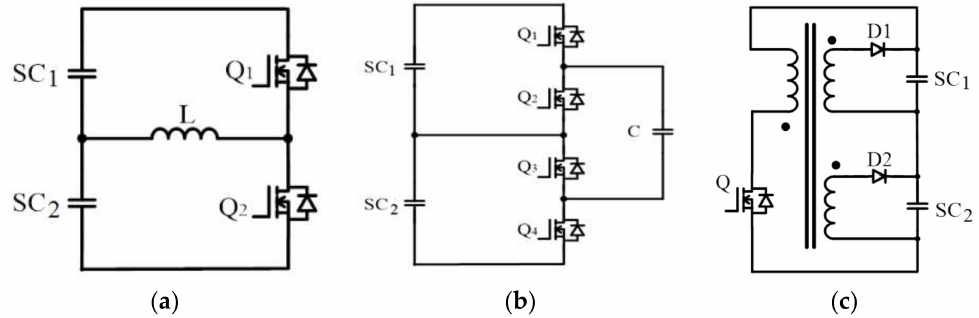
Figure 1. Basic topology of cell-balancing. ( a ) Buck-boost converter; ( b ) Capacitor balancing; ( c ) Transformer balancing.